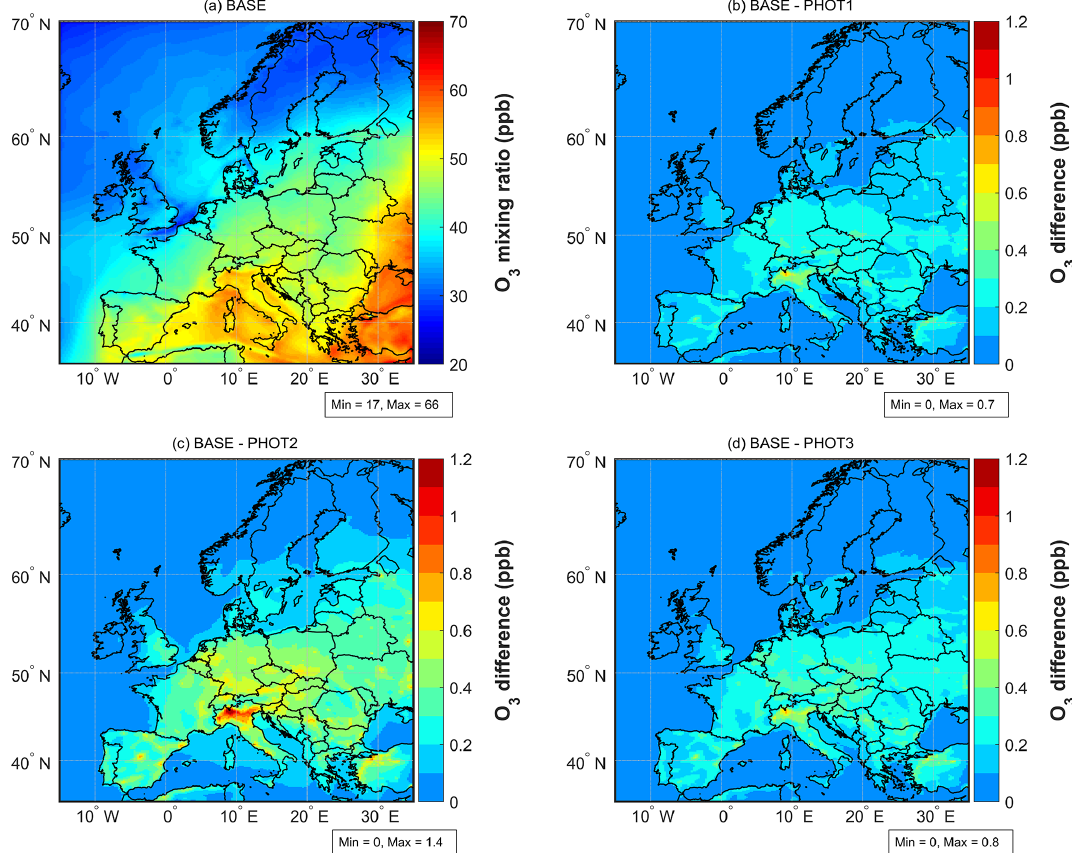
Figure 7. Seasonal daytime (10:00 − 18:00LMT) mean O 3 mixing ratios for the BASE scenario (a) and O 3 differences between the BASE scenario and the PHOT1, PHOT2 and PHOT3 scenarios (b–d) , respectively, in summer 2010. Note the different color scale between panel (a) and panels (b–d)